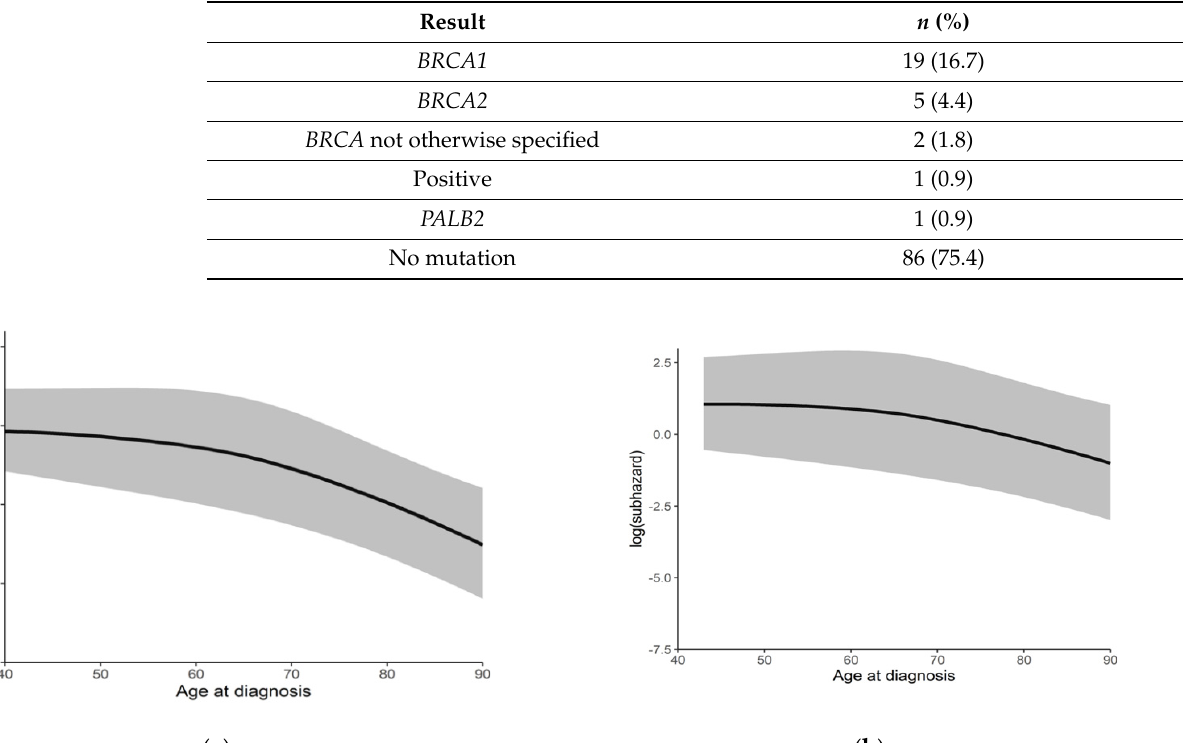
Table 3. Results of genetic testing (2004–2016), n = 114.